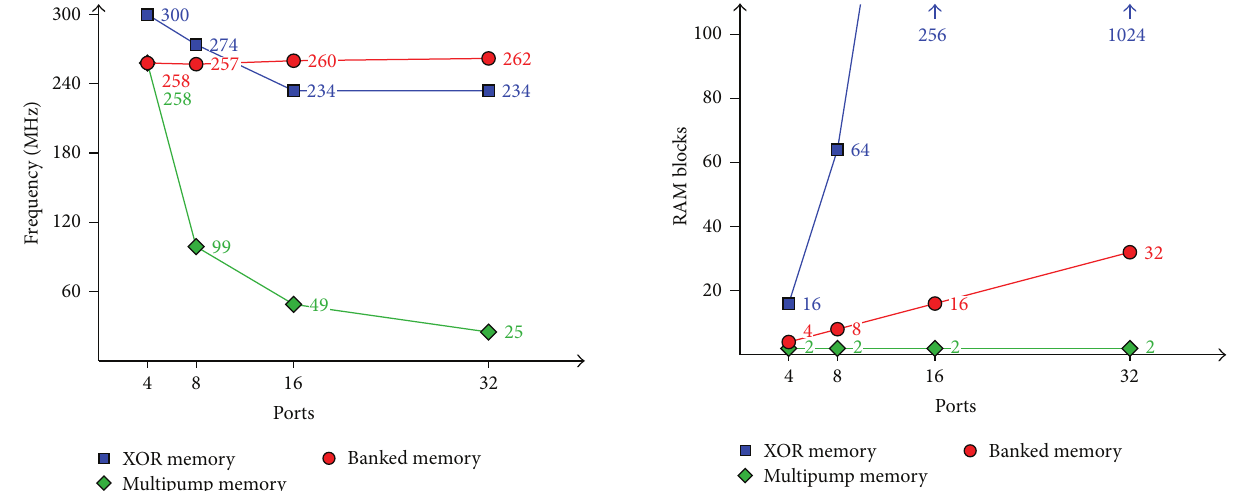
Figure 3: Max frequency for XOR, multipumped, and banked memorydesignsasthenumberofportsisvaried.Weusedtheresults of our Omega memory in Table 1 for the banked memory.